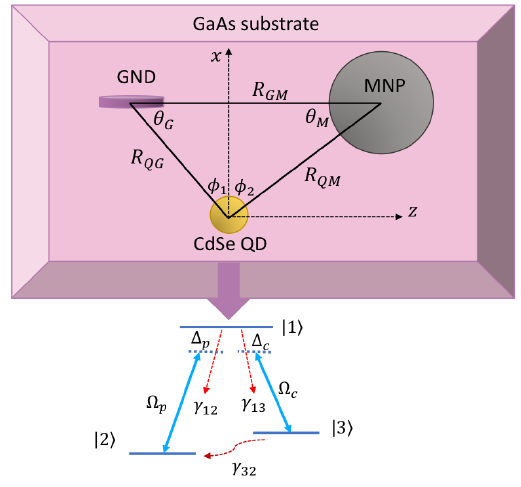
Figure 1. The proposed model of MNP-GND-QD hybrid system deposited on a GaAs